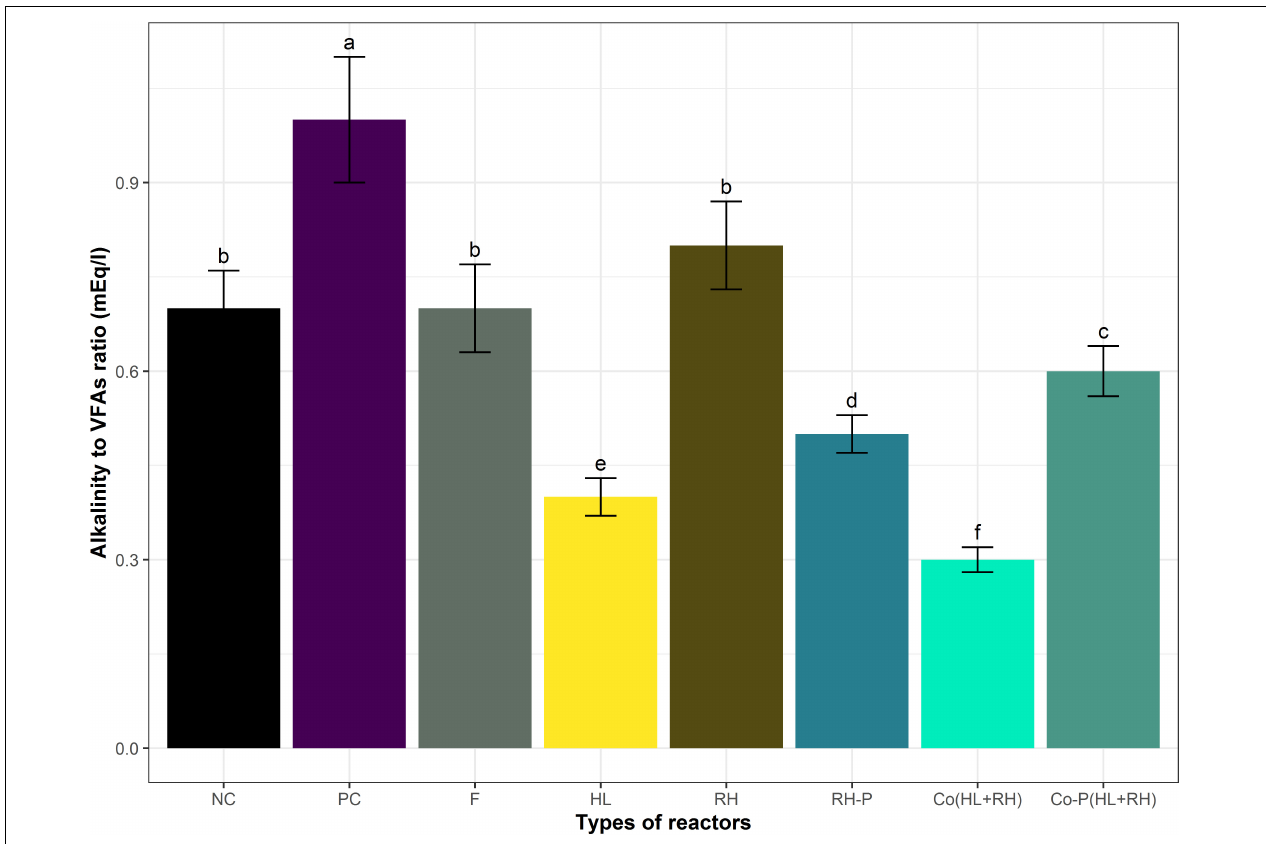
FIGURE 3 | Alkalinity to VFAs ratio of different reactors. Means having the same letter are statistically similar as per the Tukey test at p <